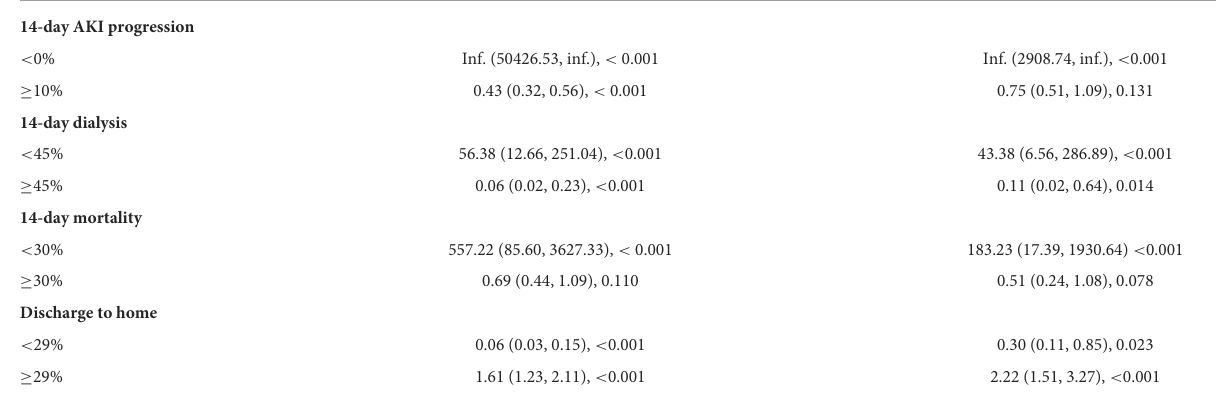
TABLE 4 The results of threshold effect analysis.